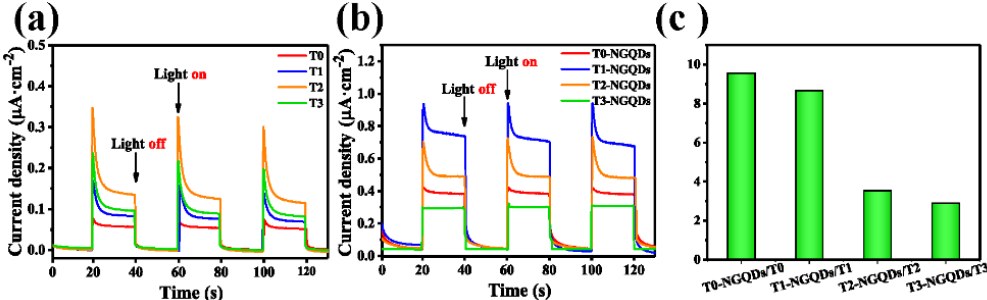
Figure 5. Periodic on-off photocurrent output of ( a ) bare anatase TiO 2 , and ( b ) TiO 2 /NGQDs composites. ( c ) The multiple times of the photocurrents of the anatase TiO 2 with and without NGQDs decoration.